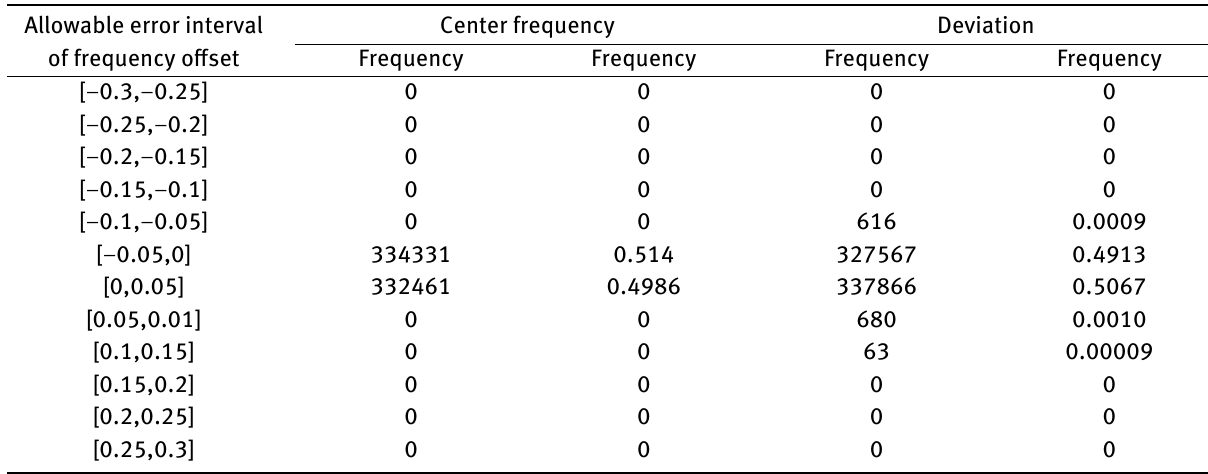
Table 4: Statistical results of 666,792 experiments of the error of the calculated values of frequency and frequency offset of domestic 18 informational centers